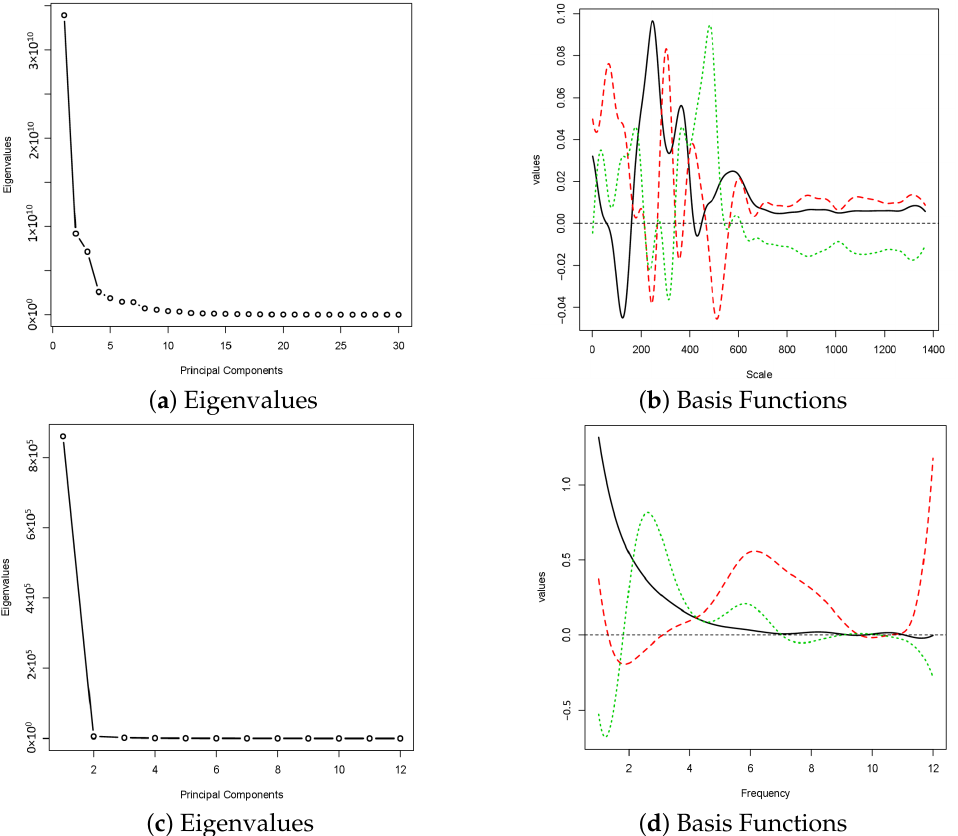
Figure 6. The eigenvalues and the first three eigenfunctions under the maximum number of basis functions for functional principal components of power spectra. The signals from Sets A, B, C and D are used. The first eigenfunction is in black, the second eigenfunction is in red and the third eigenfunction is in green. The results shown in ( a , b ) are corresponding to power spectra using CWT, while ( c , d ) are the results using